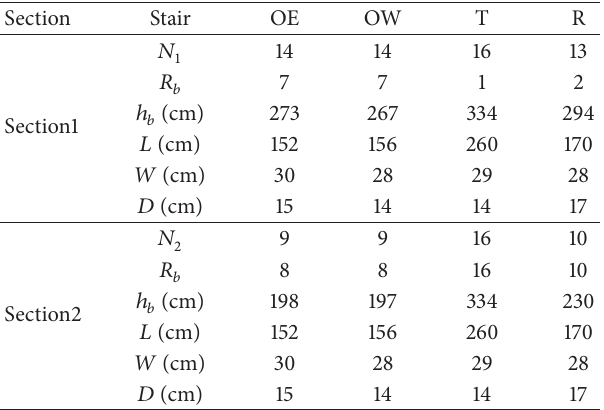
Table 1: Structure parameters of measured stair environment.